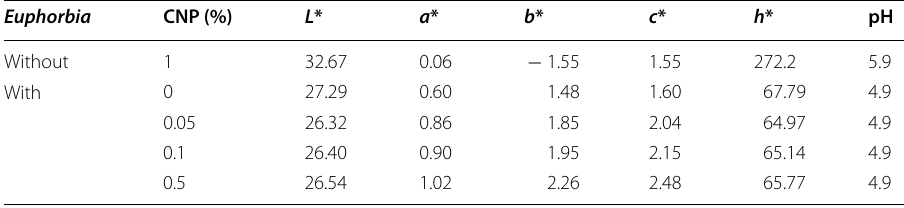
L * lightness, a * ＋ red ~ － green, b * ＋ yellow ~ － blue, c * chroma, h * hue, pH acidity